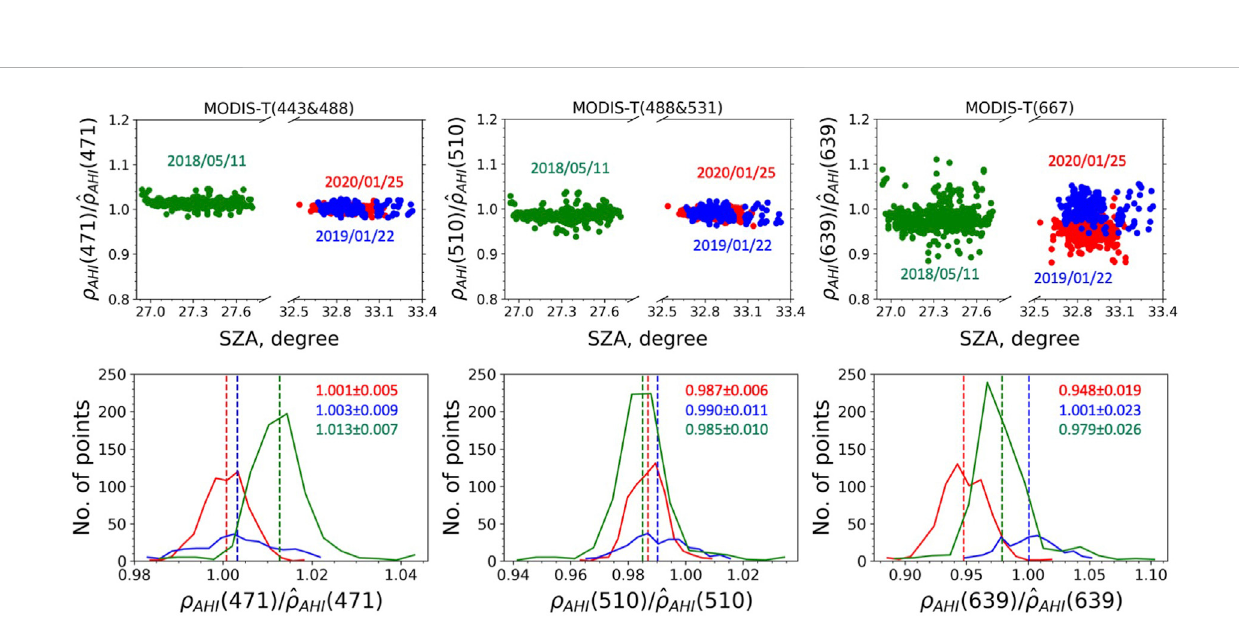
Frontiers in Remote